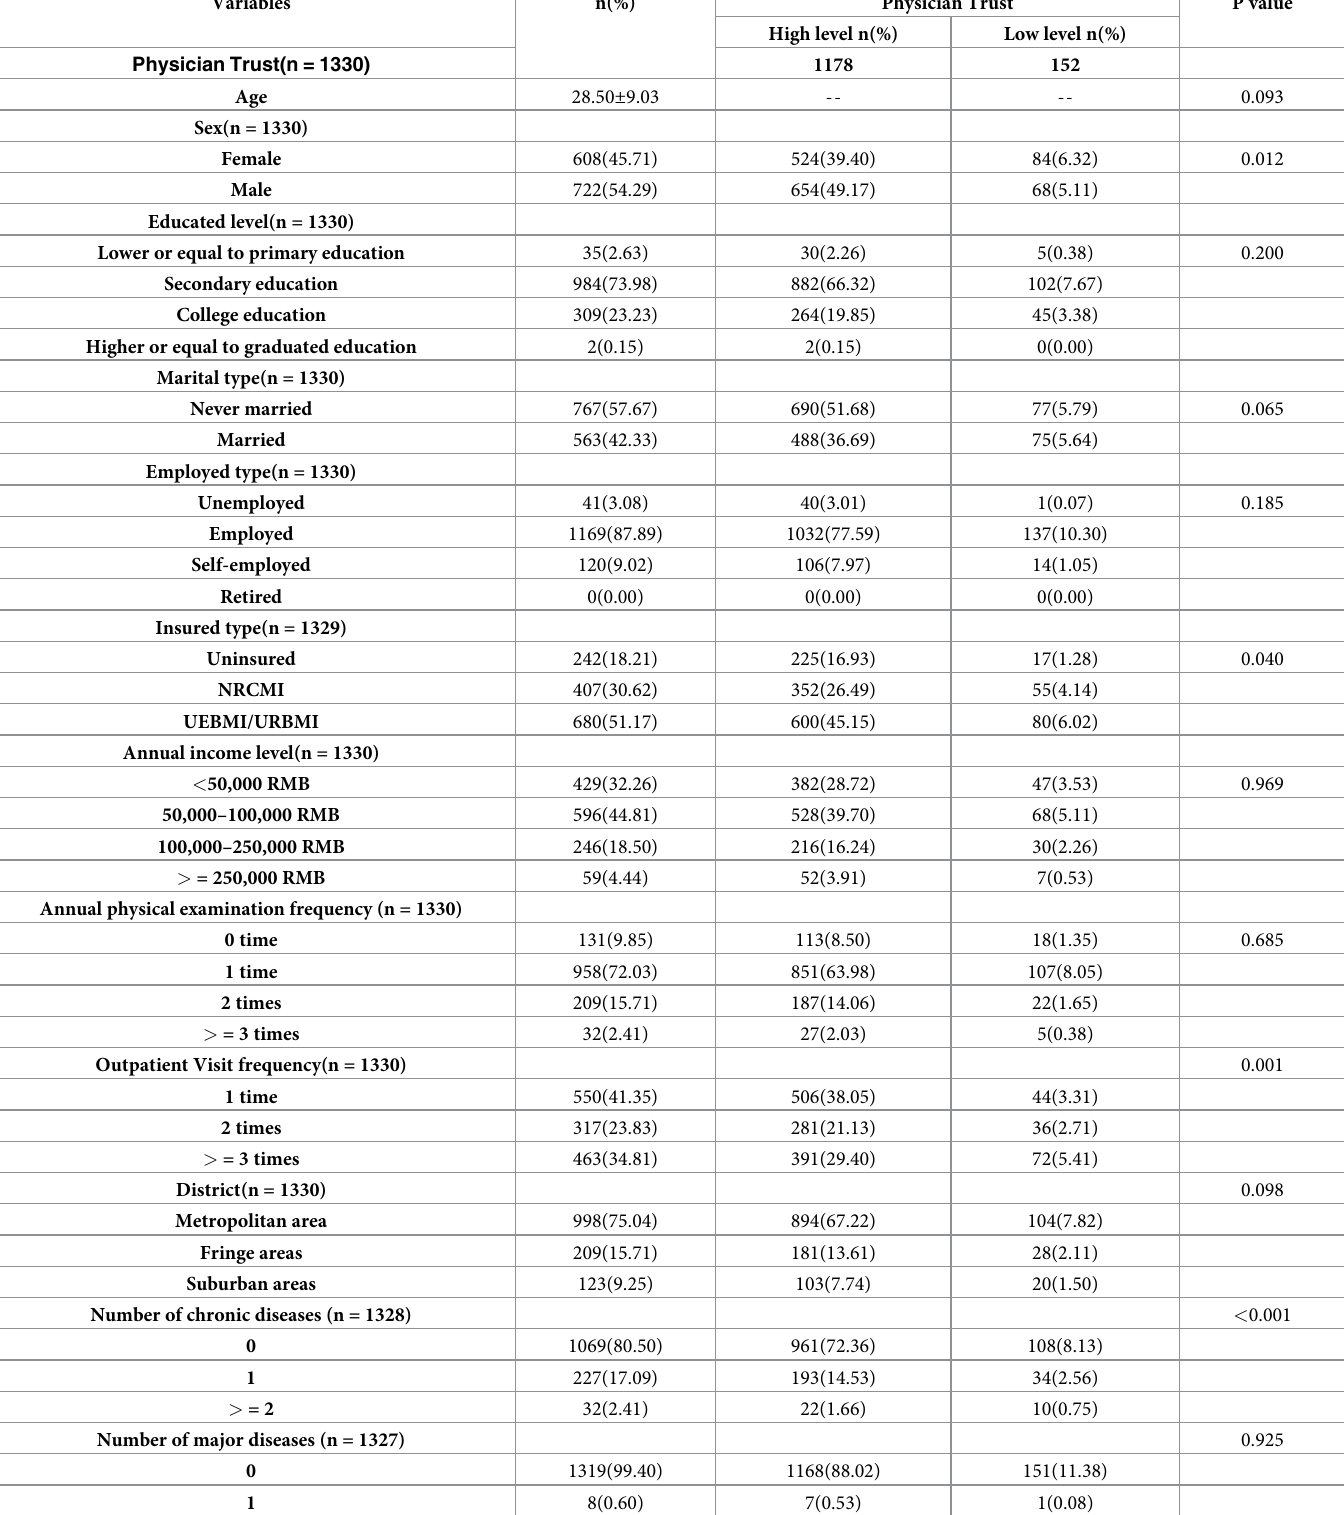
Table 1. Sample characteristics and univariate analysis of physician trust in internal migrants in Shanghai (n =